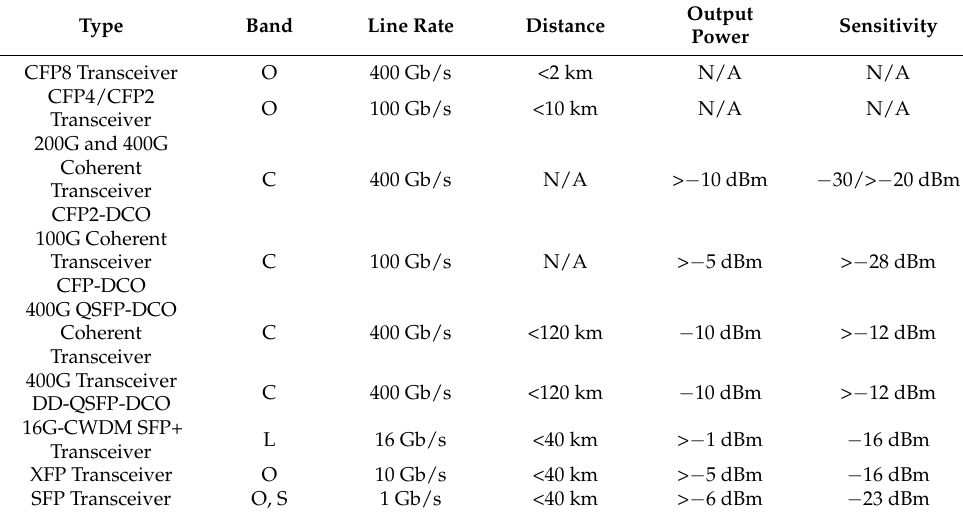
Table 12. Details of commercially available transceivers